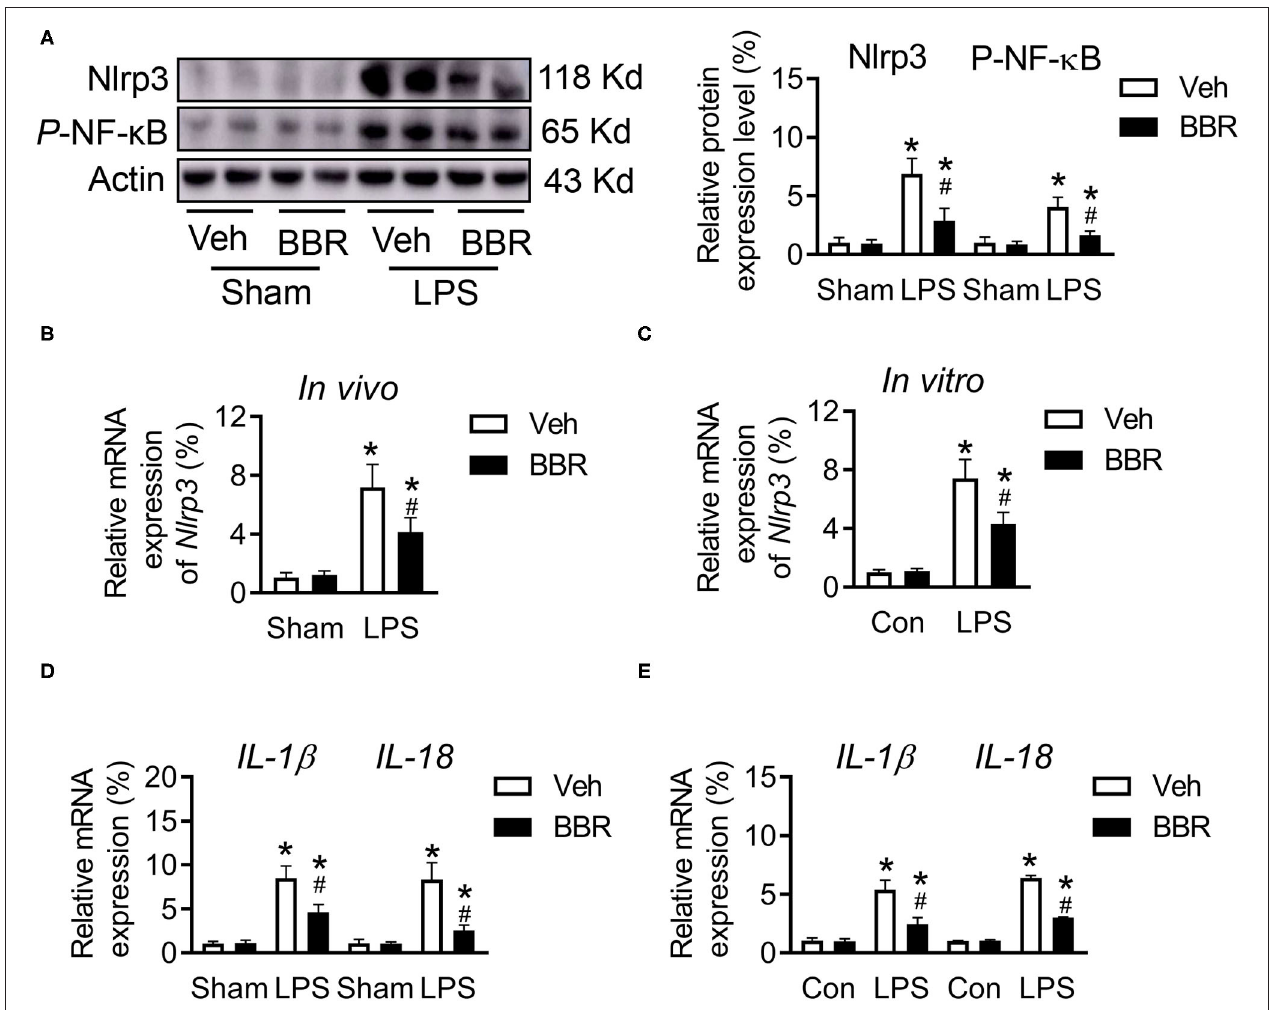
FIGURE 4 | Berberine regulated the expression of phosphorylated NF- κ B and Nlrp3 in mice with ALI. (A) The expression of Nlrp3 and p-NF- κ B at protein level in lung tissue, n = 6. (B) The mRNA expression of Nlrp3 in vivo , n = 8. (C) The mRNA expression of Nlrp3 in vitro , n = 3. (D) The mRNA expression of IL-1 β and IL-18 in lung tissue, n = 8. (E) The mRNA expression of IL-1 β and IL-18 in HPMECs, n = 3. Data were expressed as mean ± SD. Statistical significance is indicated as * P < 0.05 vs. the sham + vehicle groups, # P < 0.05 vs. the LPS + vehicle groups. infiltration of inflammation via protecting the permeability of